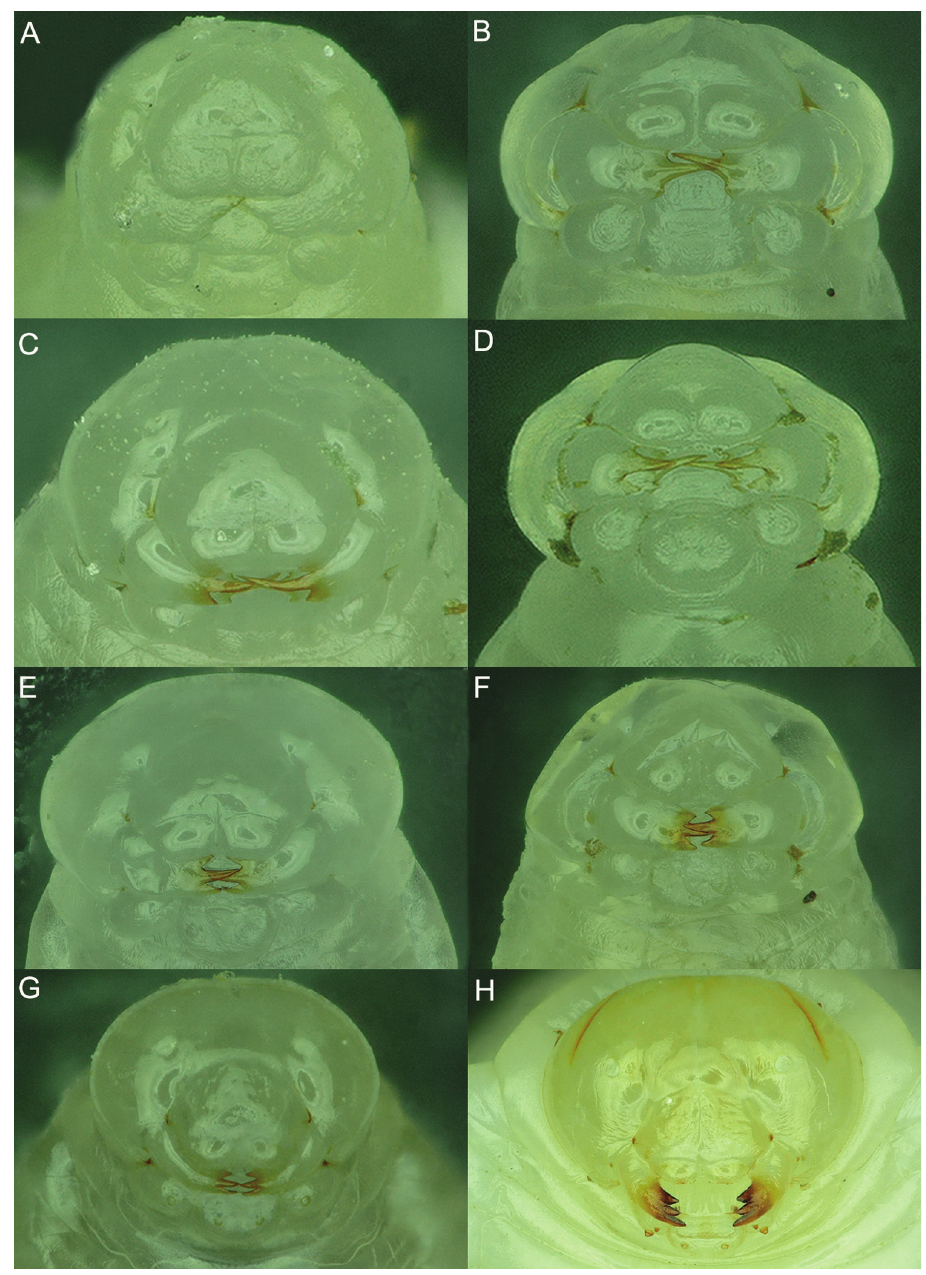
Figure 7. Vespula structor (Smith), development of mandible. A Fifth instar B second instar C–F third instar G fourth instar H fifth